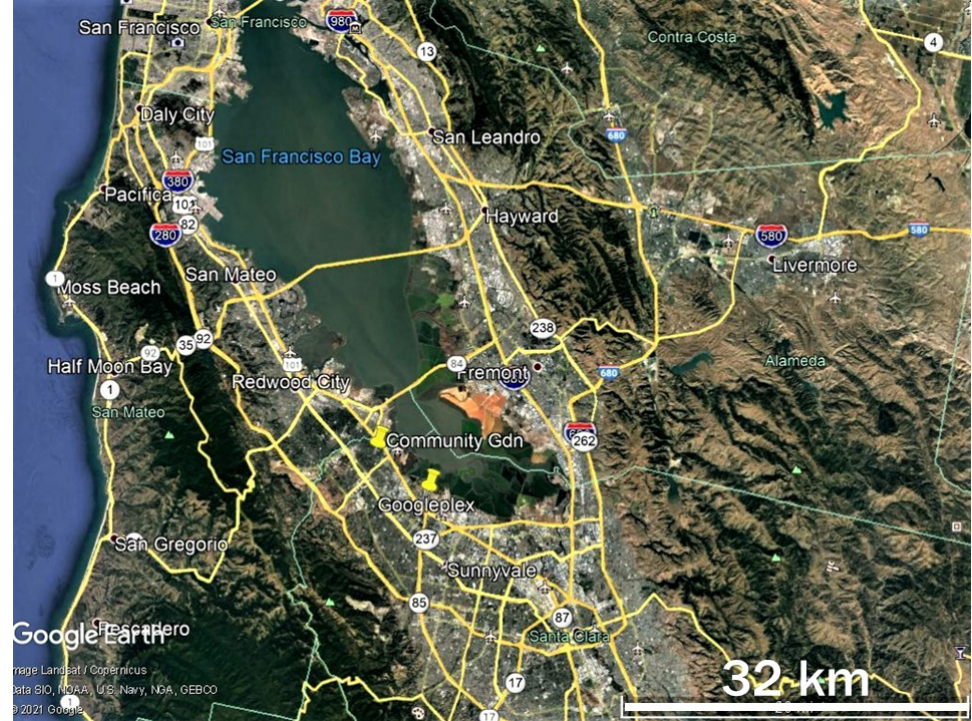
Figure 1. San Francisco Bay area showing locations in the south Bay (yellow pins) where this study was conducted January–May 2021 (Google Earth image).